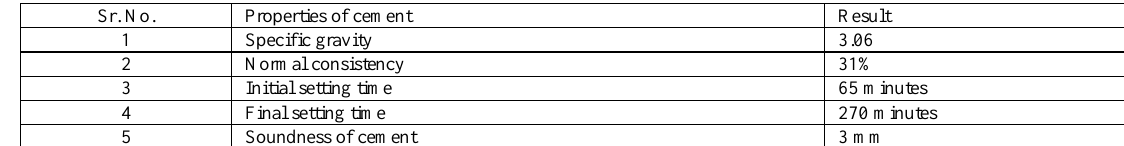
Table 5. Test results of